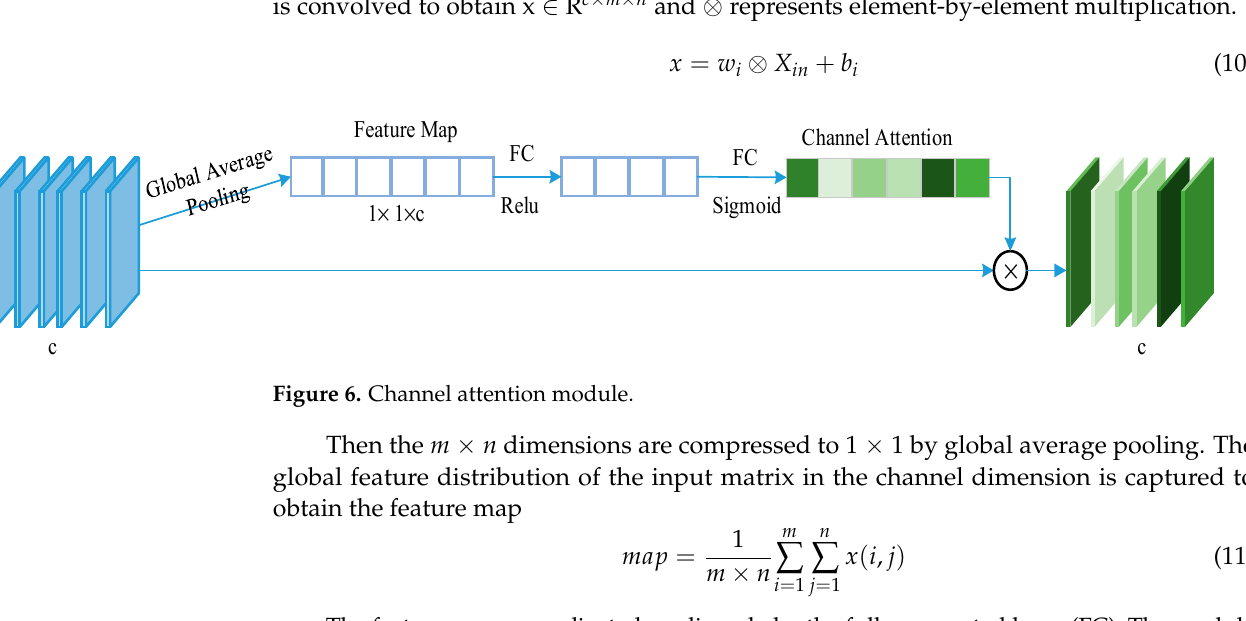
Figure 6. Channel attention module.